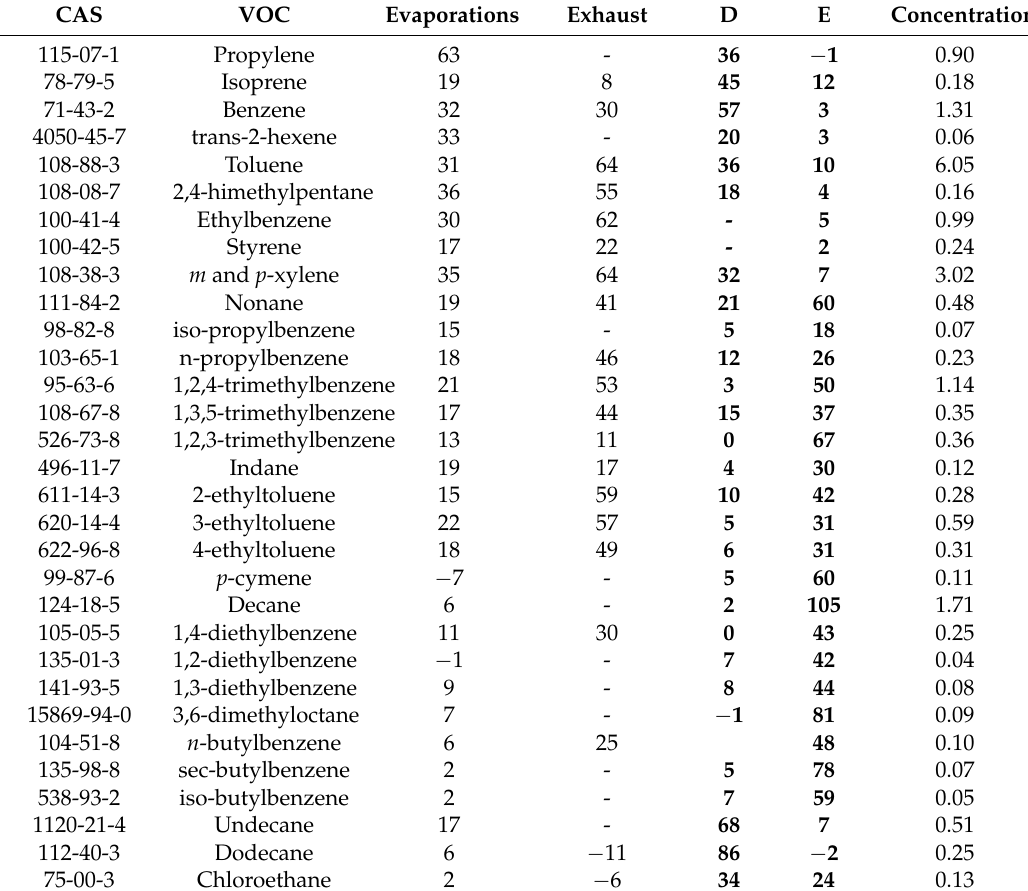
Table 8. Profiles of point sources D and E detected at station #60413, shown with the traffic